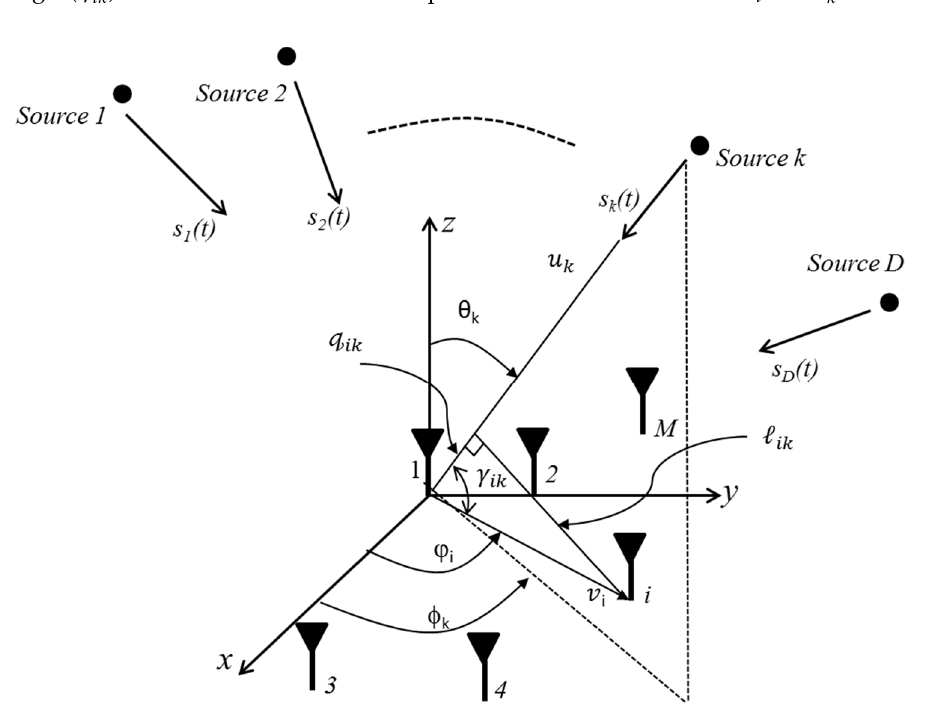
Figure 1. M-Arbitrary element array with D arriving signals.